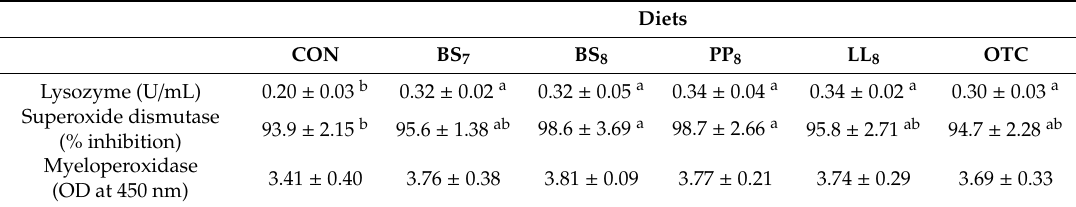
Table 5. Non-specific immune responses of juvenile whiteleg shrimp fed the experimental diets for 8 weeks 1